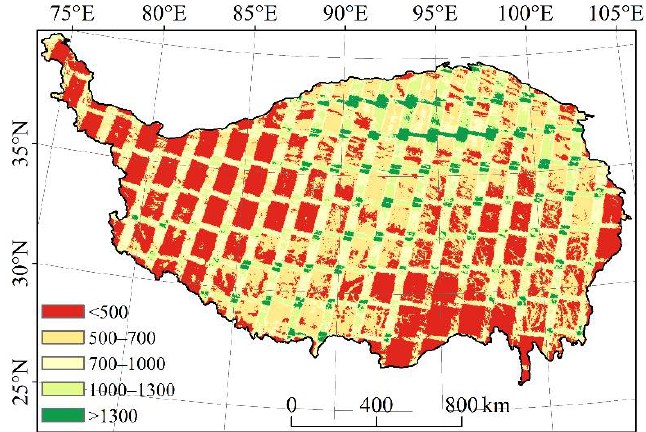
Figure 2. Counts of valid Landsat NDVI after cloud, cloud shade, and snow masking and inward buffering during 1987–2020.